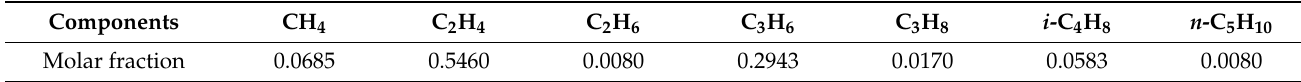
Table 2. Feed composition of the separation section.